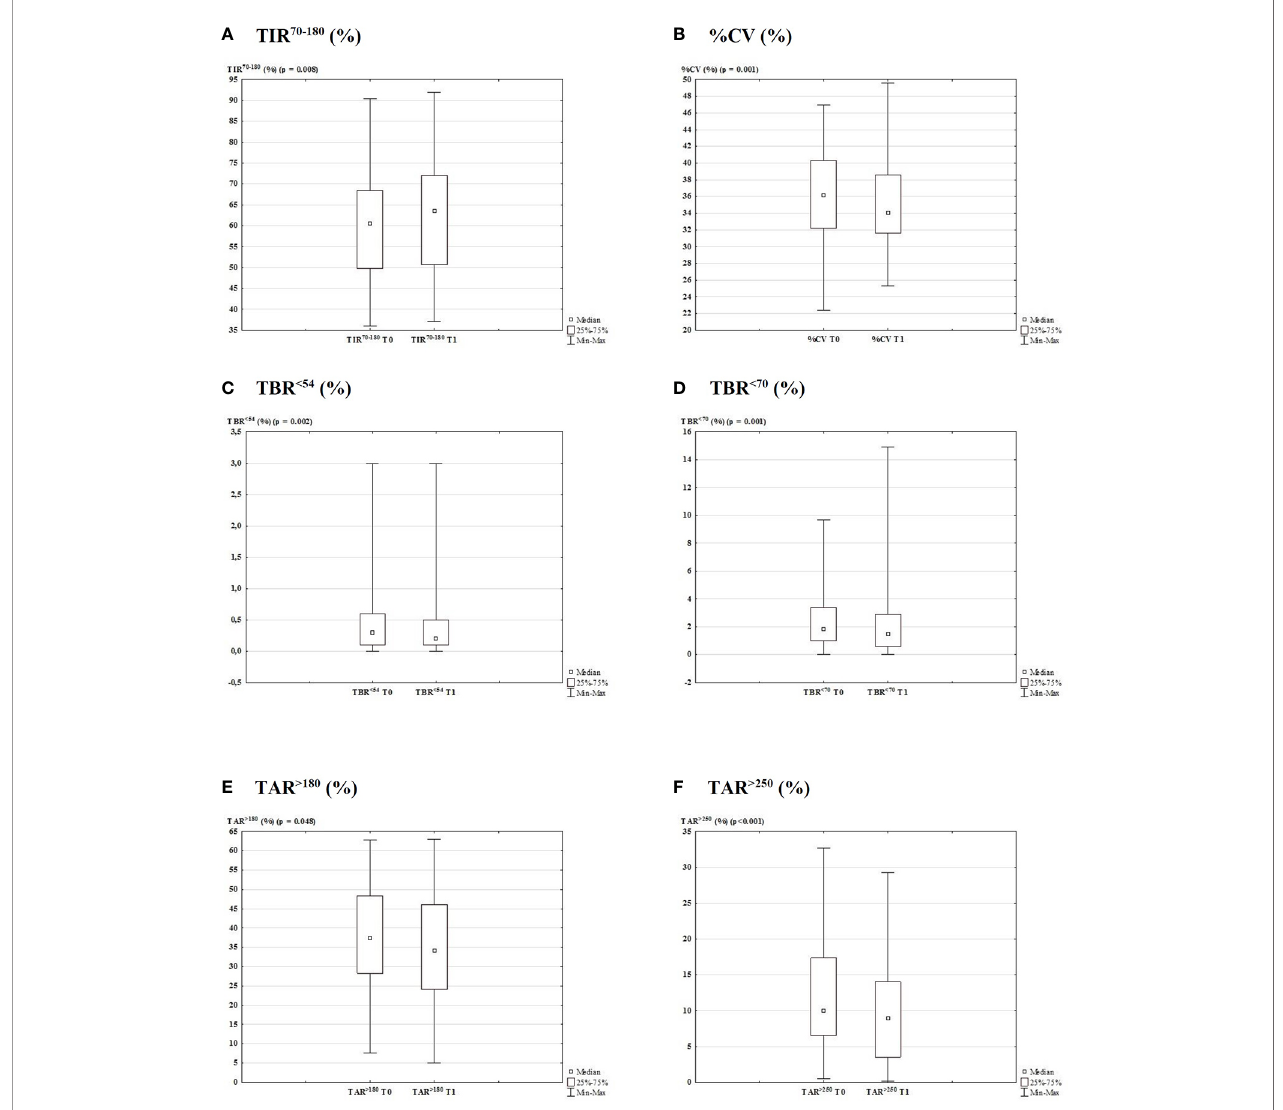
FIGURE 2 | Glycemic control data generated from the AGP report 3-months before and after lockdown due to COVID-19 outbreak (T0 vs. T1). Box plot with the percentage of TIR 70-180 ( A ; p = 0.008), CV ( B ; p = 0.001), TBR <54 ( C ; p = 0.002), TBR <70 ( D ; p = 0.001), TAR >180 ( E ; p = 0.048), and TAR >250 ( F ; p <